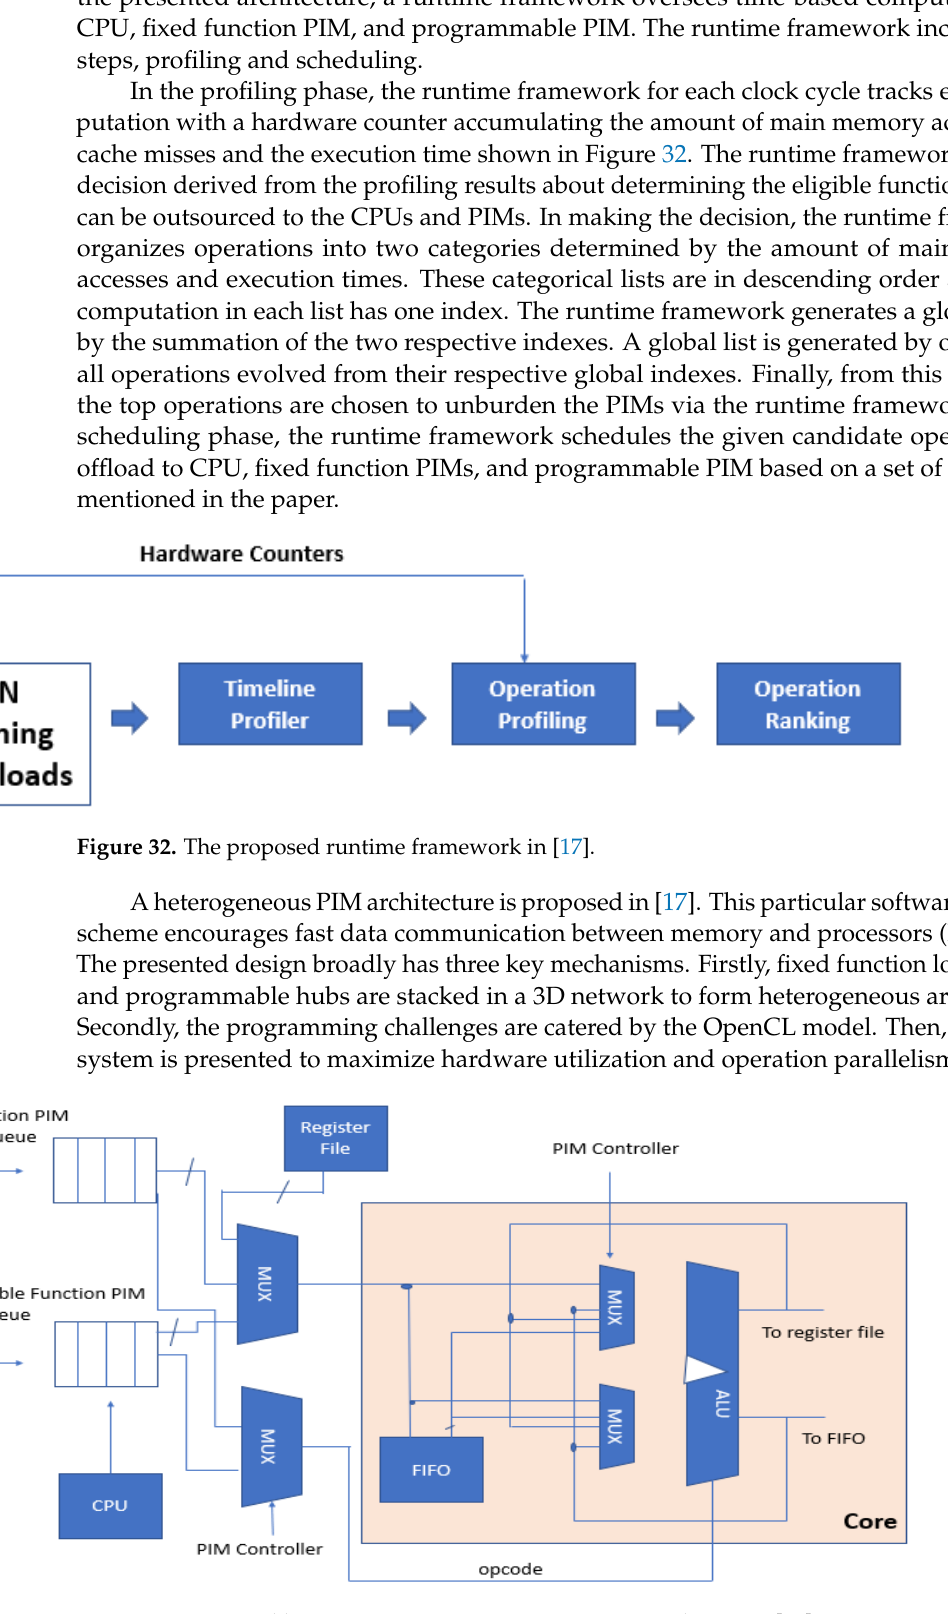
Figure 33. Proposed heterogenous processing-in-memory architecture [17]. The runtime system proposed in [17] includes two main features. Firstly, it includes a pipeline scheme to simultaneously run multiple neural network operations. Secondly, it also includes a recursive method to call the fixed function PIMs. Hardware utilization is considerably improved through these topographies.